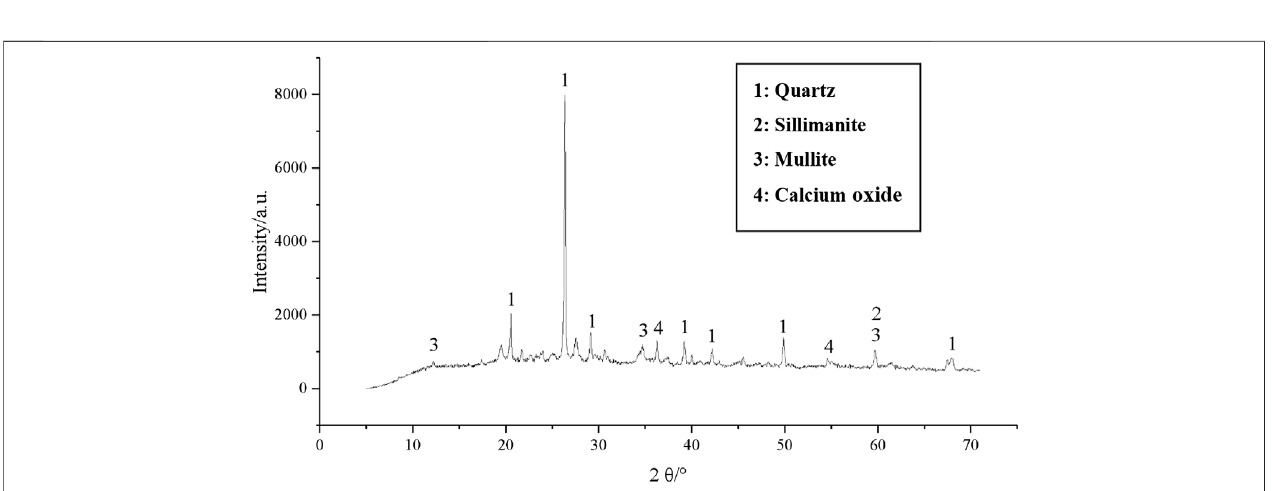
FIGURE 17 | XRD pattern of the one-part geopolymer-stabilized soft clay with 80% GGBFS and 20% FA at 6.50 mol/L NH solution for 14 days.